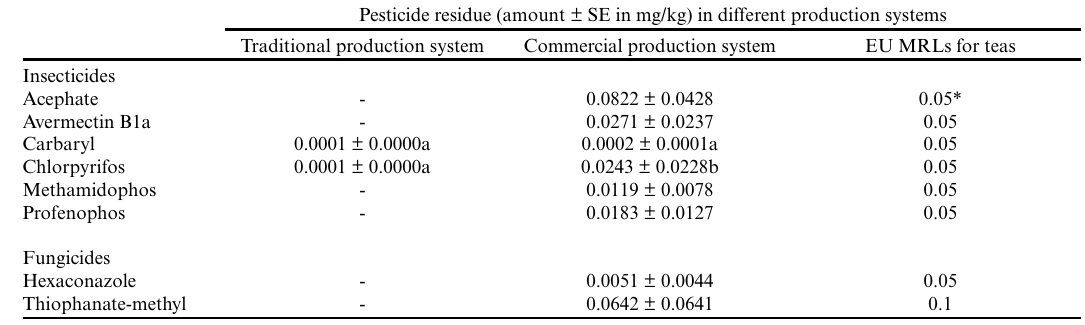
Table 1 . List of pesticide residues from khat samples grown under traditional and commercial production systems. Note: MRL = maximum residue limits.